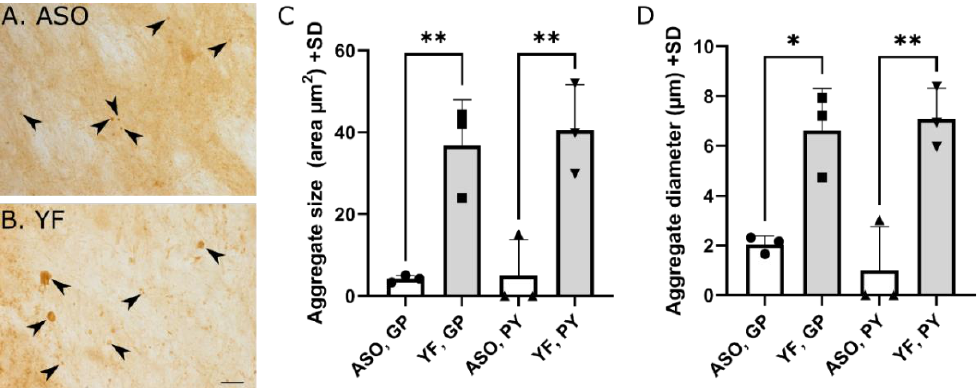
Figure 7. Quantification of aggregates in 8-month-old ASO and YF mice. Quantification of aggre- gates size ( C ) and diameter ( D ) of the ASO ( n = 3) and YF ( n = 3) mouse at 8 months of age stained for α -synuclein using antibody against full-length α -synuclein (ASY6). Measurements performed in brain regions containing the globus pallidus (GP) and pyramis (PY) at the pontine level. Examples of aggregates are marked with arrowheads ( A , B ). When measured in terms of aggregate areas or diameters, aggregates are clearly larger in the YF mouse. Data are depicted as mean + standard deviation (SD); the variance did not differ between experimental groups and, thus, data was analyzed with one-way ANOVA with a multiple comparisons test. * p < 0.05, ** p < 0.01. Scale bars: ( A , B ), 50 µ m.